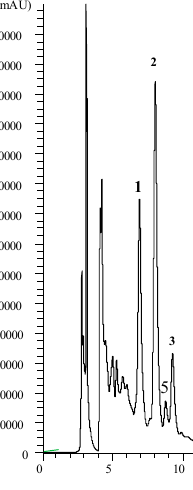
Figure 1. Chromatographic profile of the hydroethanolic extract obtained from purslane stems, recorded at 330 nm. Peak numbers correspond to the compounds already mentioned in Table 5.